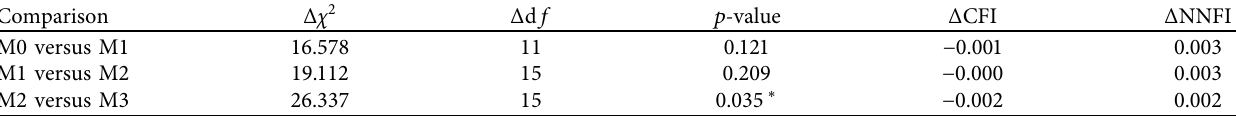
Table 11: Model comparisons for multisample structural equation models (male versus female).